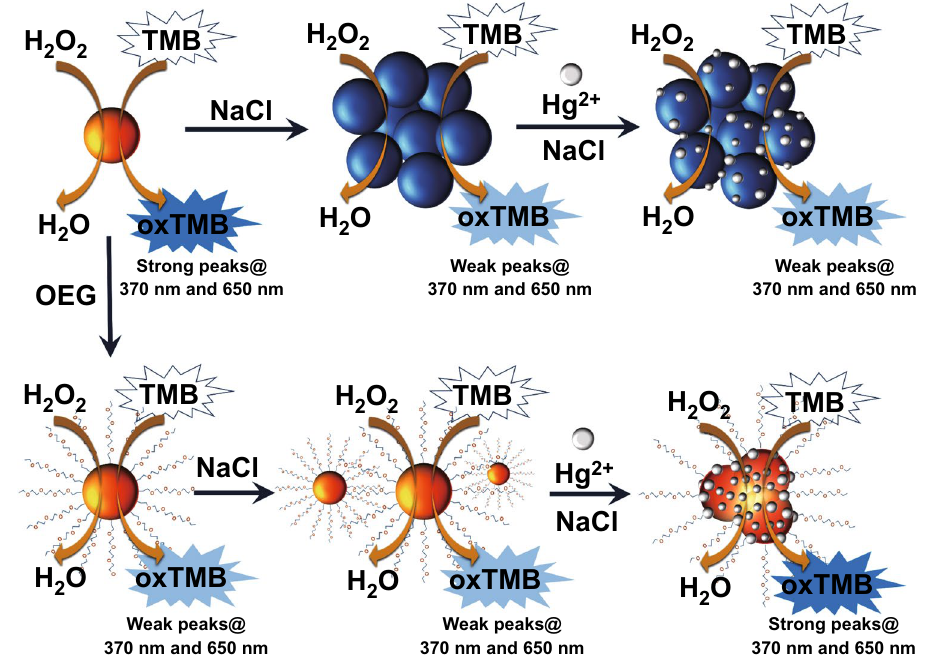
Fig. 11 Colourimetric sensor using gold nanozymes for the detection of Hg 2+ ions in seawater samples [183]. Copyright 2020 Logan et